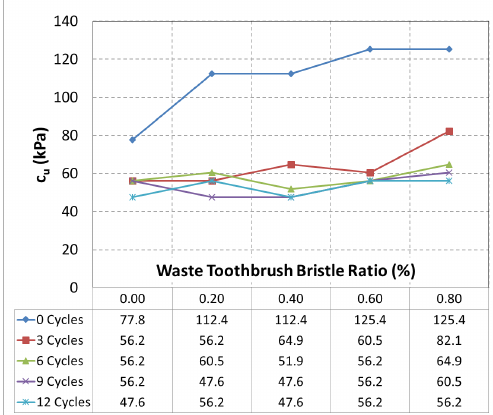
Figure 4: Unconfined compression test: (a) unreinforced sample (9 cycles), (b) reinforced sample (toothbrush bristles 0.8% ratio, 9 cycles).